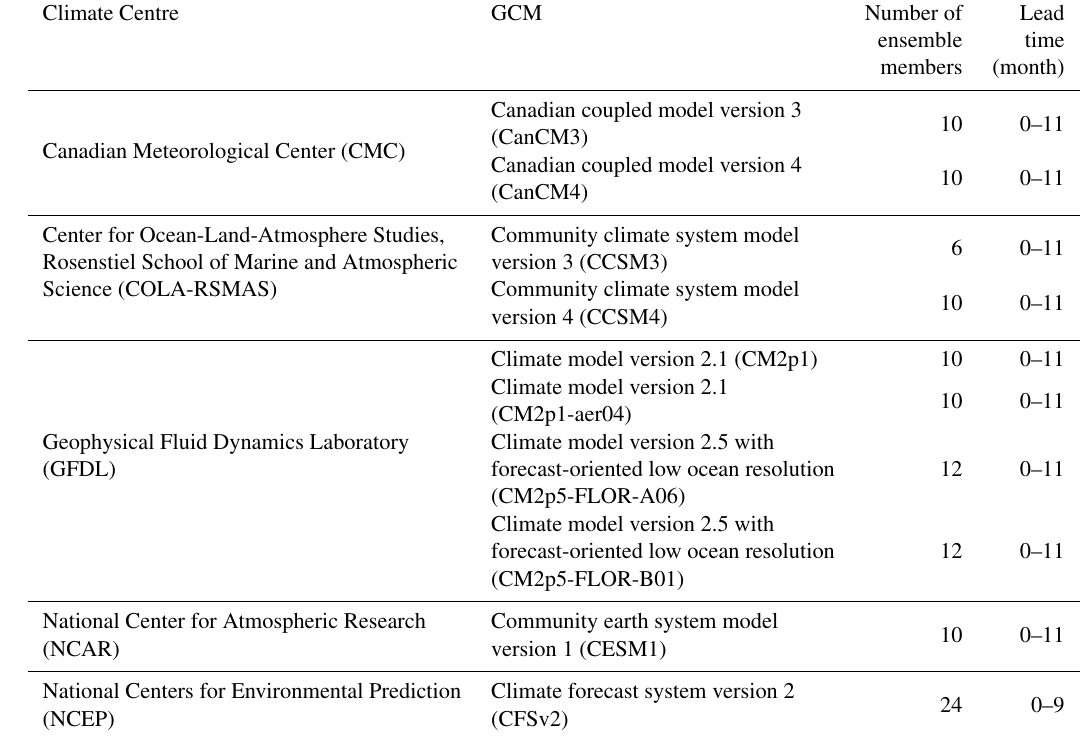
Table 1. Basic information on the 10 sets of GCM forecasts from the NMME